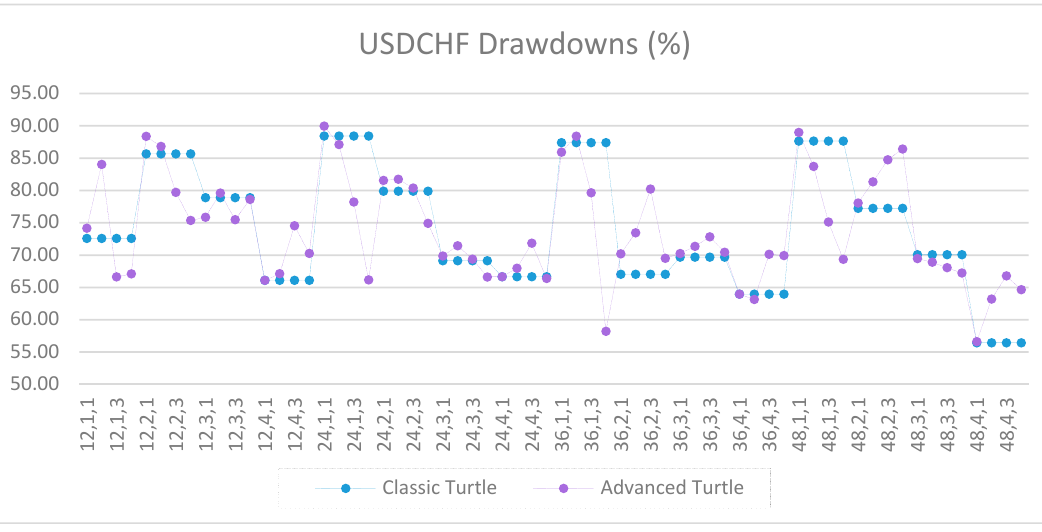
Figure A40. Drawdowns of USDCHF as percentage of equity between the classic and the advanced Turtle systems for every combination of N, X, Y for the slow parameters (80, 160).